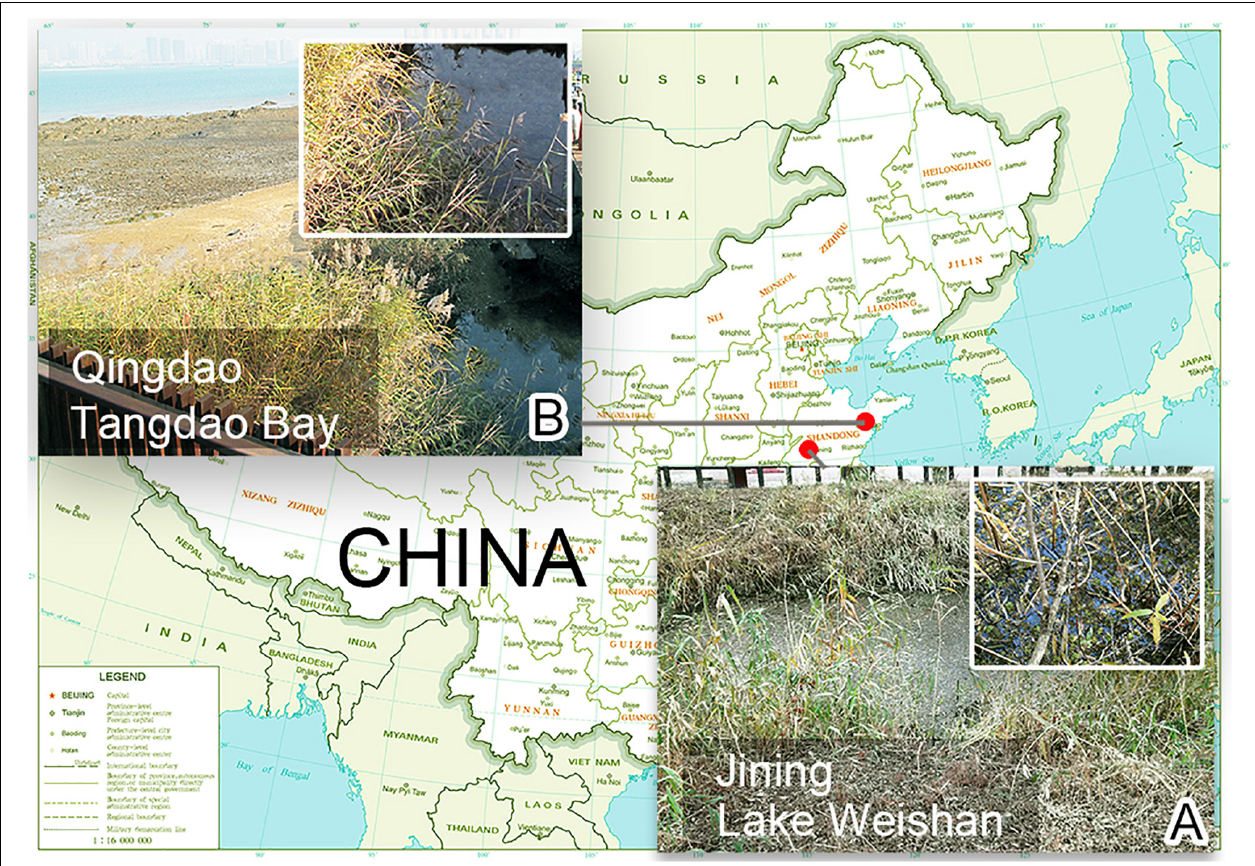
FIGURE 1 | Locations of sampling sites. (A) Surroundings of the sampling site of Lake Weishan, the city of Jining, where Heterobakuella bergeri gen. nov., sp. nov. was collected. (B) Photograph of Tangdao Bay, the city of Qingdao, where Anteholosticha perezuzae sp. nov. was